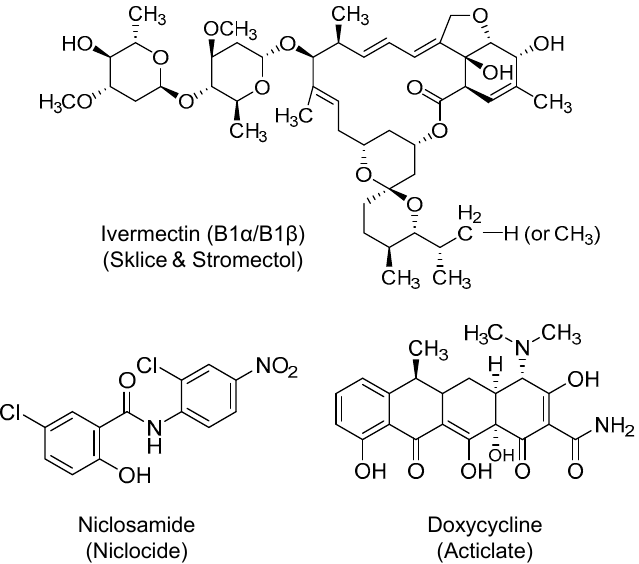
Figure 8. The chemical structures of a broad-spectrum antiparasitic agent (ivermectin), an aryl nitro-based antiparasitic agent (niclosamide), and a broad-spectrum antibacterial agent (doxycycline). Doxycycline also exhibits potential anti-inflammatory effects.